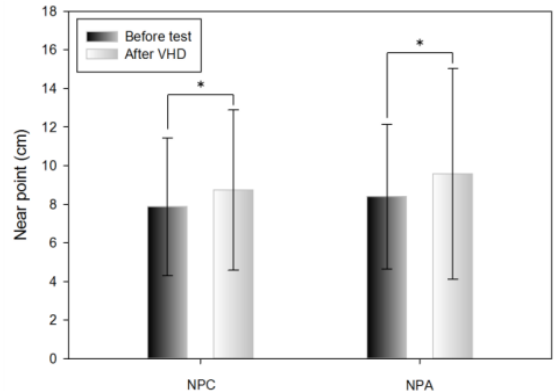
Figure 6. Near point change after VHD test (*: p<0.05)